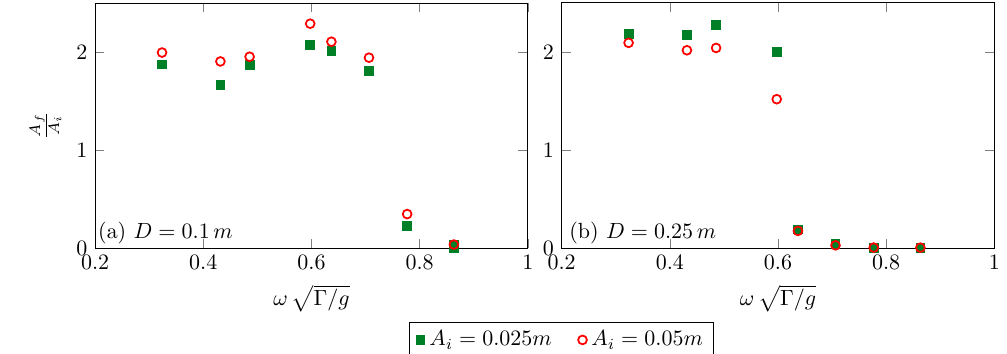
Figure 11. Impact of the wave amplitude on floater 5 (experimental results), h = 0.6 m, Γ = 0.25 m. ( a ) D = 0.10 m; ( b ) D = 0.25